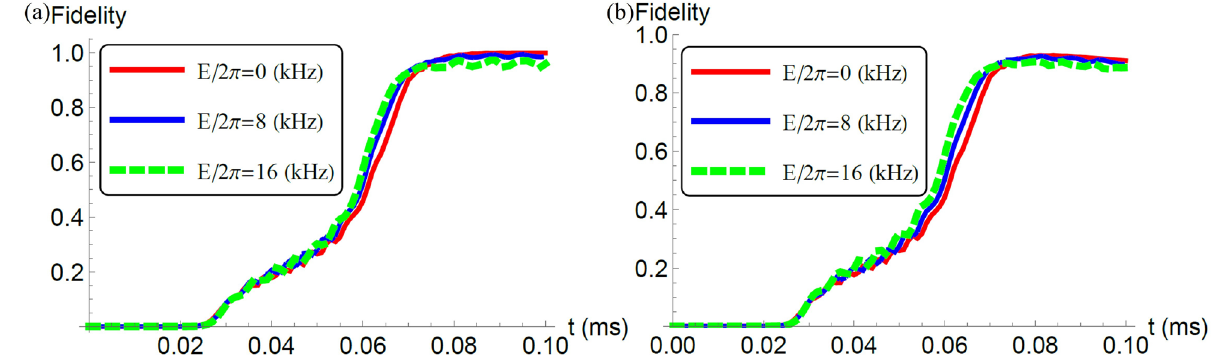
Figure 3. ( a ) We plot a fidelity against the time with the unit of milliseconds where we adopt the 200 kHz, Hamiltonian without a rotating wave approximation. We set the parameters as L = 3, D ′ 0 / 2 π = ( 2 ) 2 π 60 kHz, 1.2 , E ( 3 ) 1.2 , J 12 / 2 π 30 kHz, J J ′ 23 / 2 π E ( 1 ) x / 2 π E kHz, E ( 2 ) x / E ( 1 ) x J 23 / 2 π x / E x = ′ 12 / = = = = = = 0.2 T , T 0.1 ms, γ 40 MHz. ( b ) We plot a fidelity 8 , B / 2 π 340 kHz, σ 0 , and ω J 12 / J 13 J ′ 12 / J ′ 13 = = = = = = = 0.5 kHz. We use the same parameters as that used in against the time under the effect of decoherence with γ = ( a ) except the decoherence rate.